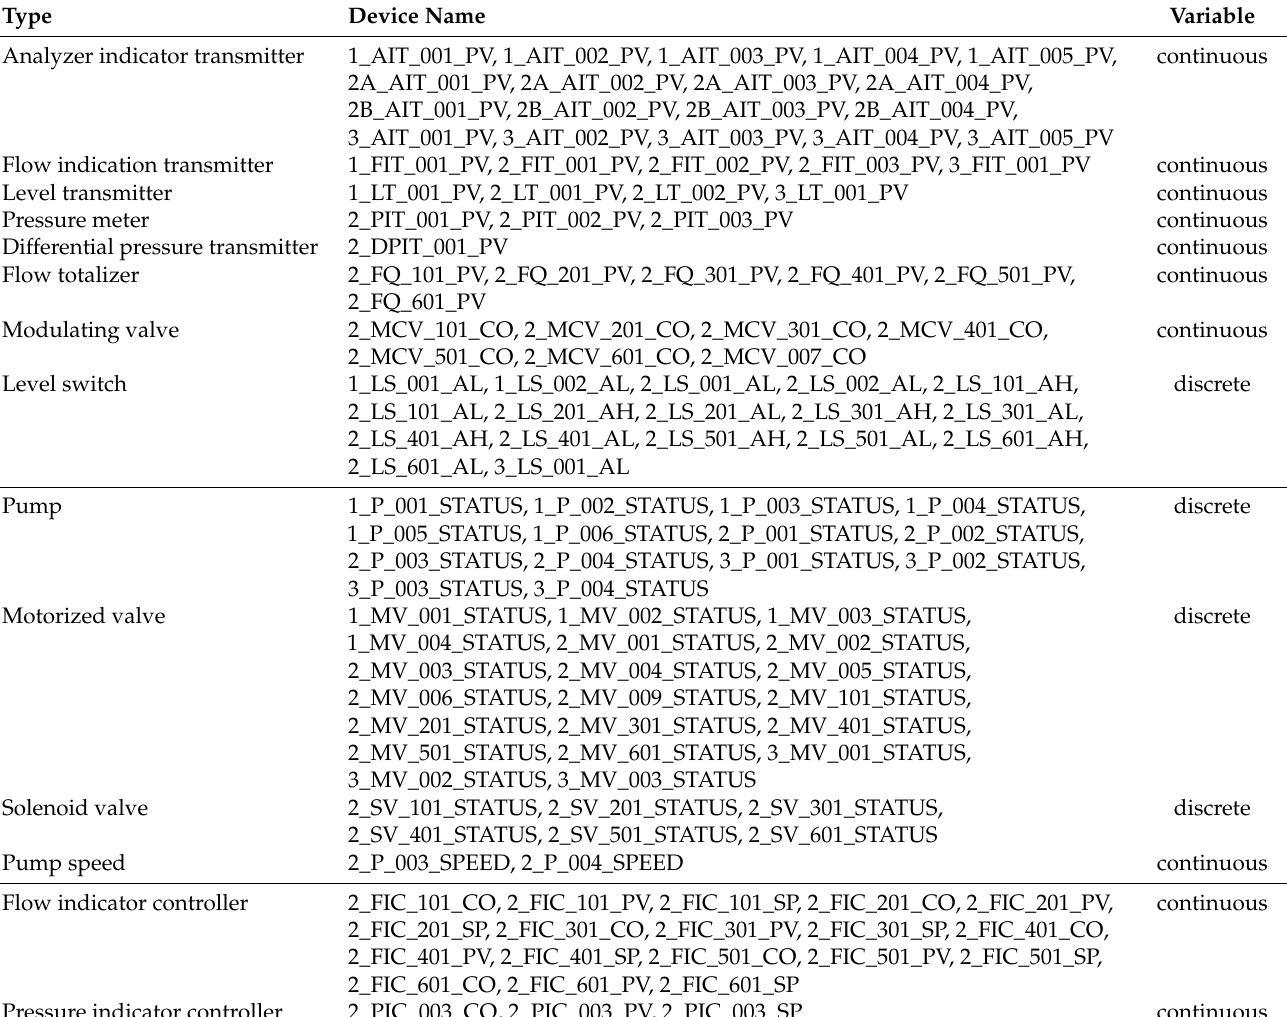
Table 3. Sensors, actuators, and controllers of the WADI